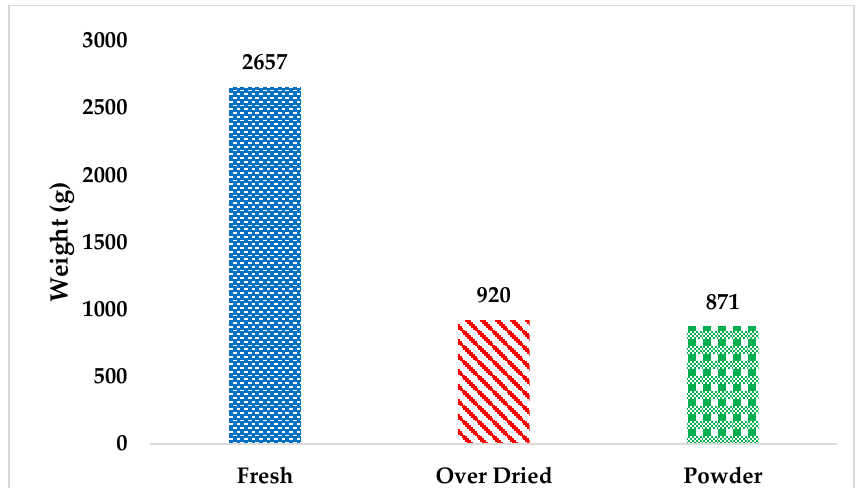
Figure 1. Weight of banana peels at different stages.